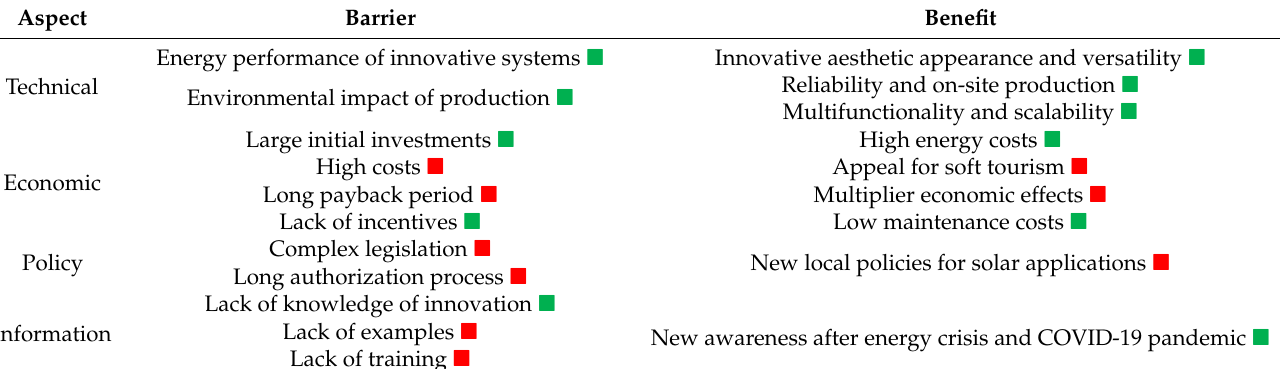
Table 2. Barriers and benefits for the social acceptance of active solar energy applications on architec- tural heritage (Source: Author’s elaboration). Barrier